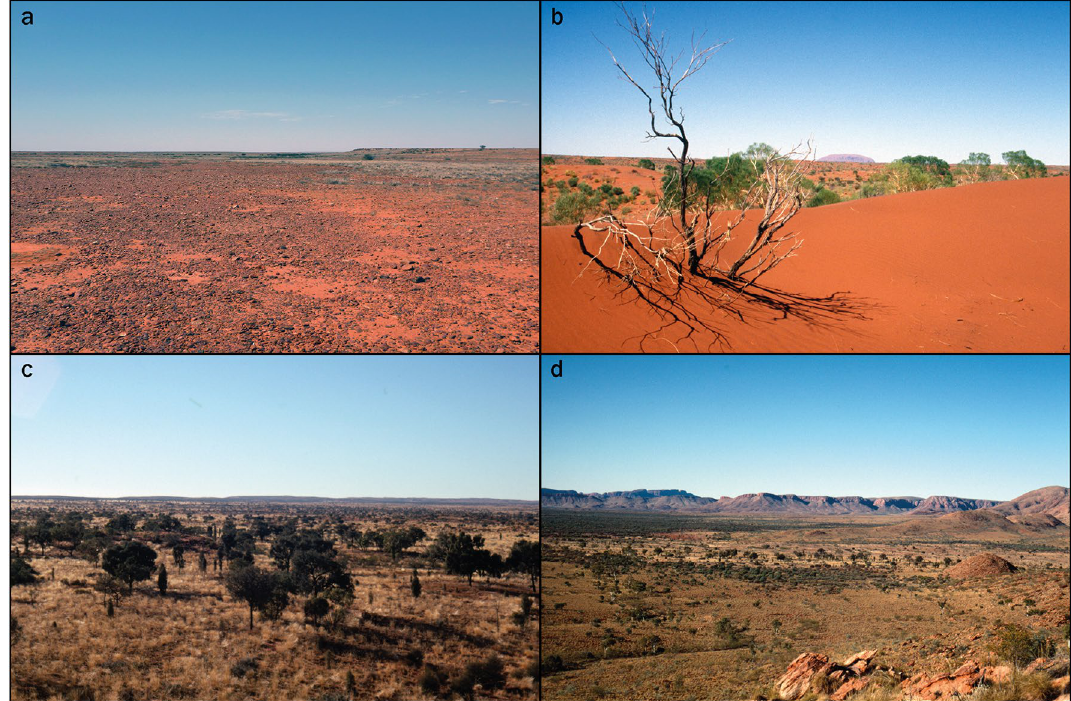
Figure 2. Photographic examples of coarse scale land systems of the Australian Western Desert. ( a ) Stony desert plains with scarce vegetation or substantial overstory. Vegetation is concentrated along drainages. ( b ) Sandridge desert with extensive linear dunefield. Dune ridges carry sparse perennial vegetation, while interdunal swales have intermittent, often dense ephemeral growth. ( c ) Sandplain lowland deserts with hummock grasslands ( Spinifex spp.) and patchy Acacia spp. overstory. ( d ) Montane uplands and lower intra- upland areas. Intra-upland areas are more easily traversed and the vegetation patterning is similar to